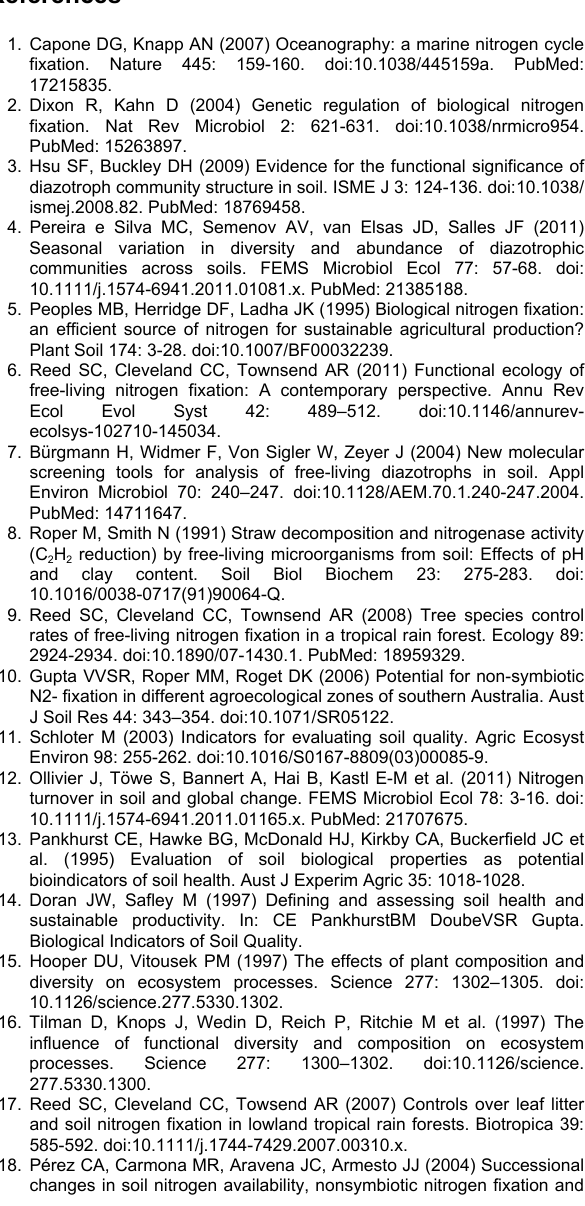
Table S4. Forward and reverse barcoded primers used for pyrosequencing of nif H gene.